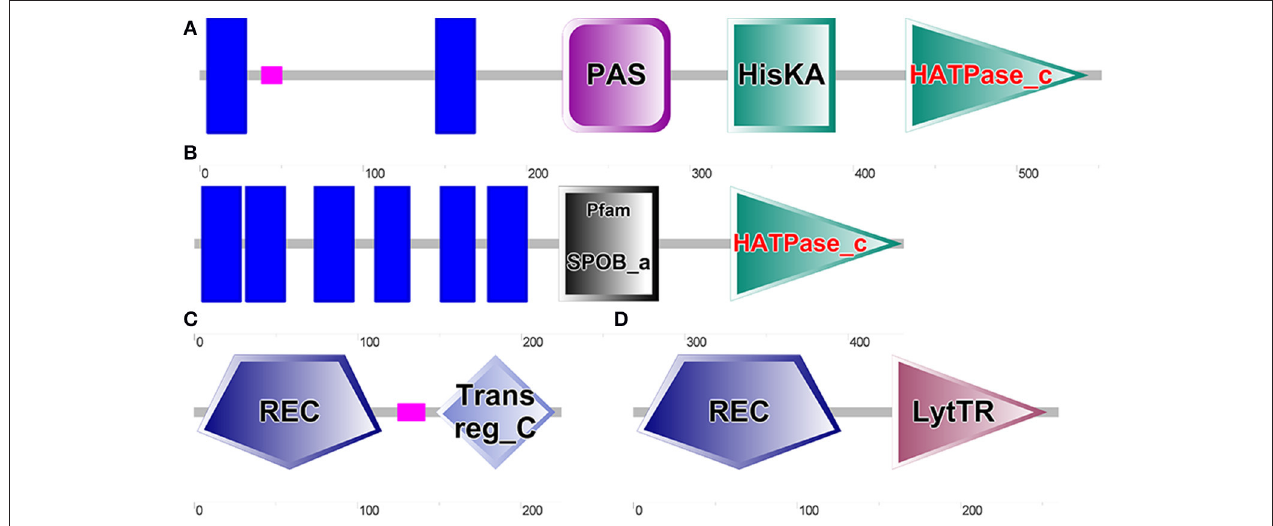
FIGURE 5 | Results of SMART analysis of four proteins. (A) . WP_011543855.1 (Encoded by LBUL_RS04160, CDS Region in Nucleotide: 811449-813107); (B) WP_011677872.1 (Encoded by LBUL_RS00115, CDS Region in Nucleotide: 23723-25027); (C) WP_003620064.1 (Encoded by LBUL_RS04155, CDS Region